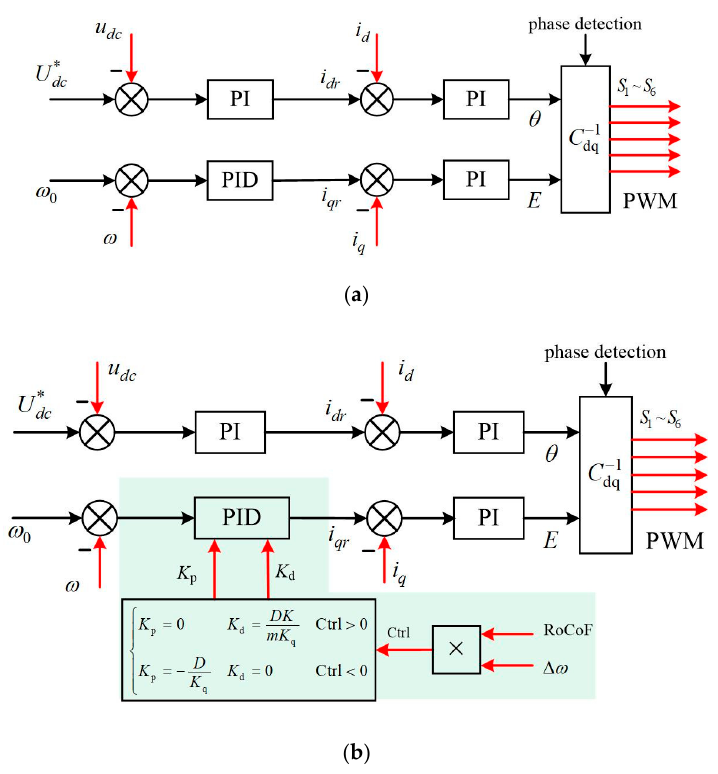
Figure 2. Control diagram of an ESS with the feedback signal of the rotor speed. ( a ) Conventional control with fixed controller parameters; ( b ) Proposed control with variable controller parameters.